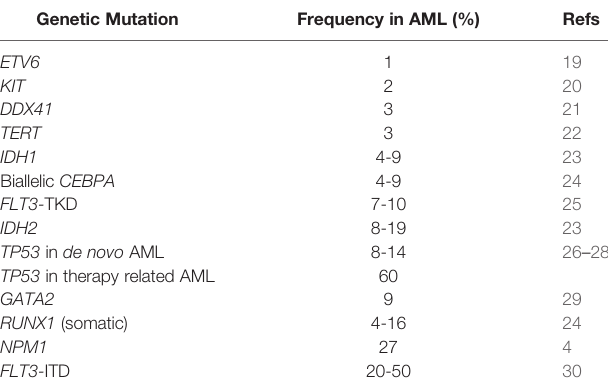
TABLE 2 | Summary of distribution of frequencies of genes mutations in Acute Myeloid Leukemia. Genetic Mutation